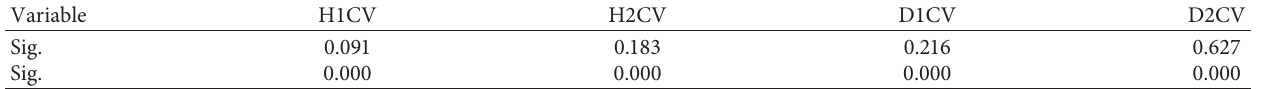
Table 4: Significance of homogeneity of variance test and analysis of variance between groups.